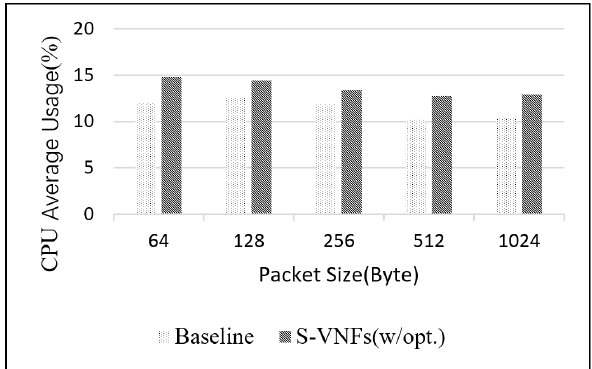
Figure 8. CPU usage of the system at different packet